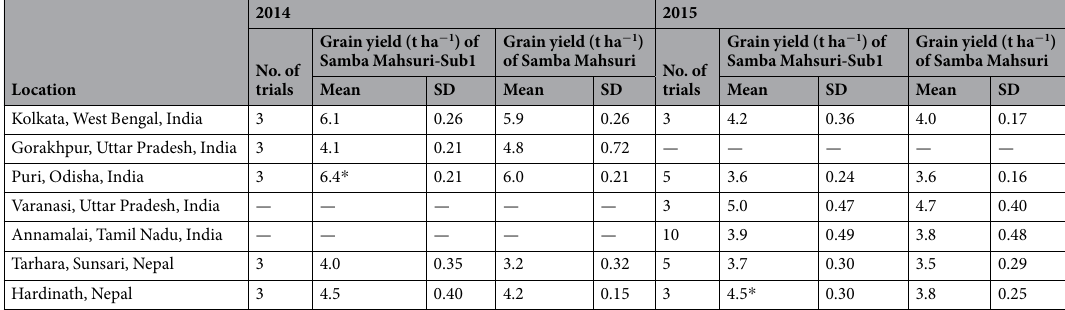
Table 2. Comparative yield of Samba Mahsuri-Sub1 and Samba Mahsuri under head to head trials during the wet seasons of 2014 and 2015. * Indicates that the grain yield is significantly higher than the parental variety at level, p =